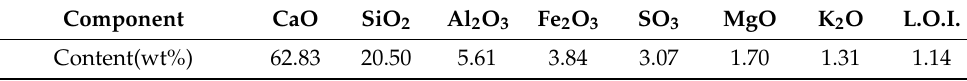
Table 1. Chemical compositions of Ordinary Portland Cement (OPC). Table 2. Chemical compositions of fly ash. Table 2. Chemical compositions of fly ash.